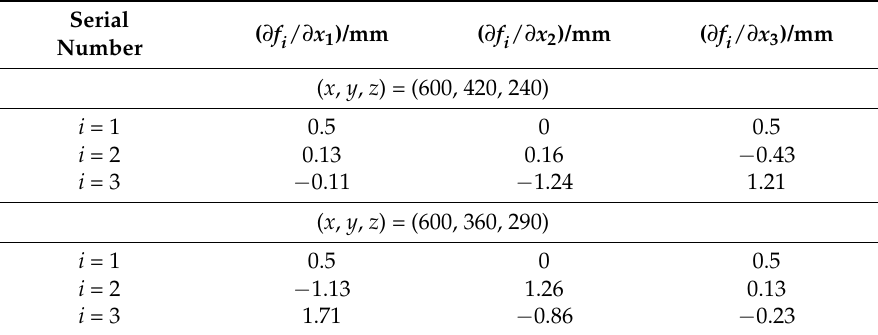
Table 1. Error transfer coefficient of two points.